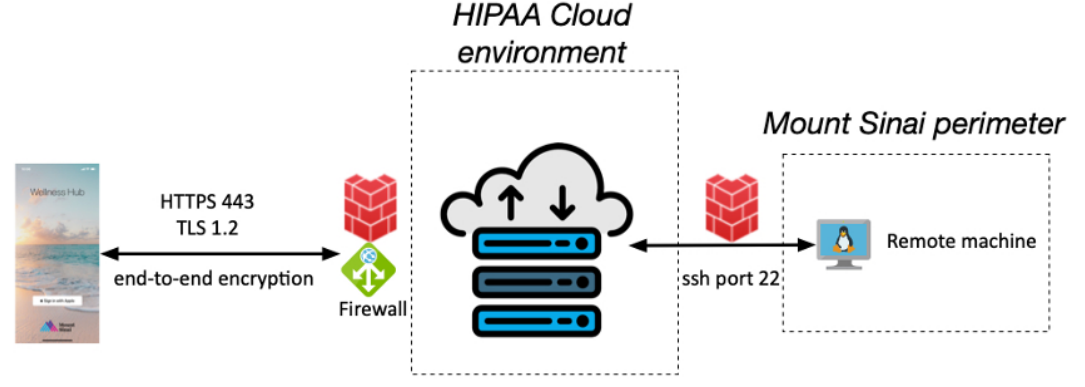
Figure 4. Data ingestion diagram. HIPAA: Health Insurance Portability and Accountability Act; ssh: secure shell; TLS: Transport Layer